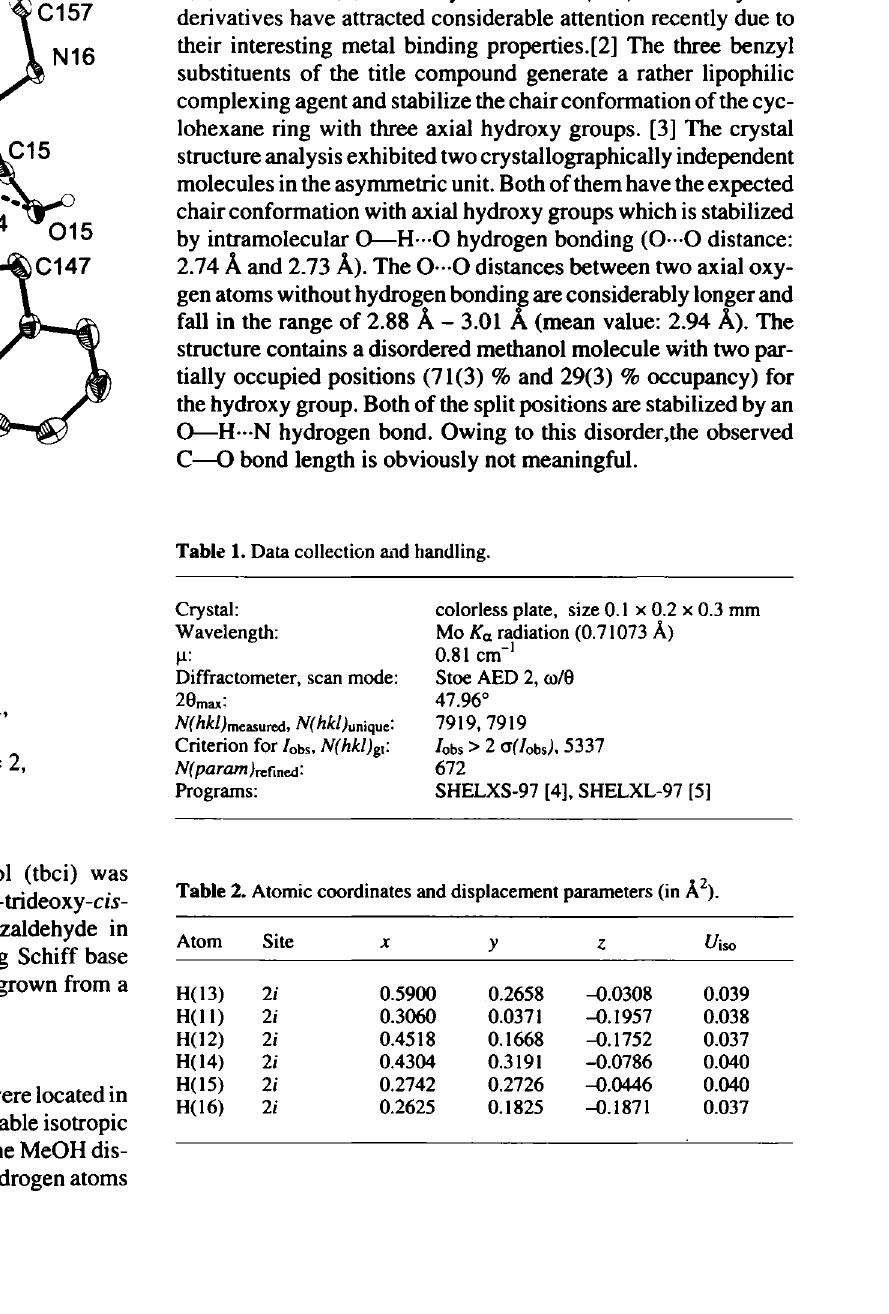
Table 2. Atomic coordinates and displacement parameters (in A 2